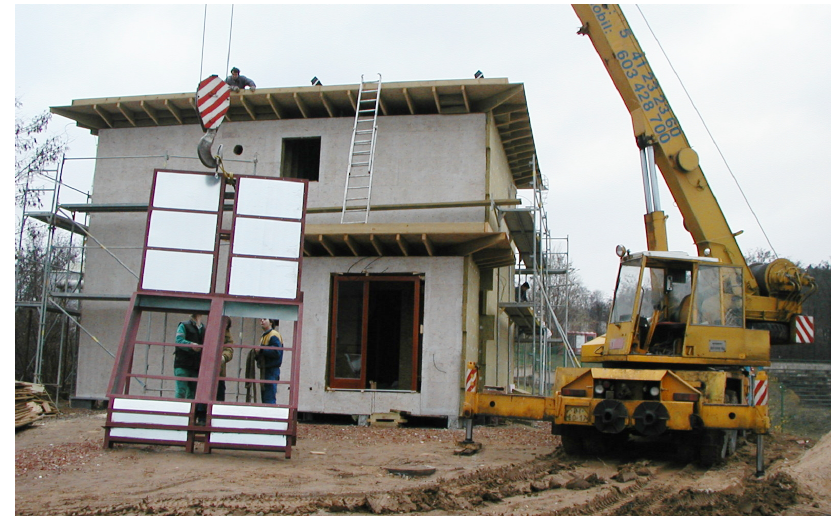
Figure 8. Installation of an experimental solar chimney on the roof of a demonstration house with a hybrid ventilation